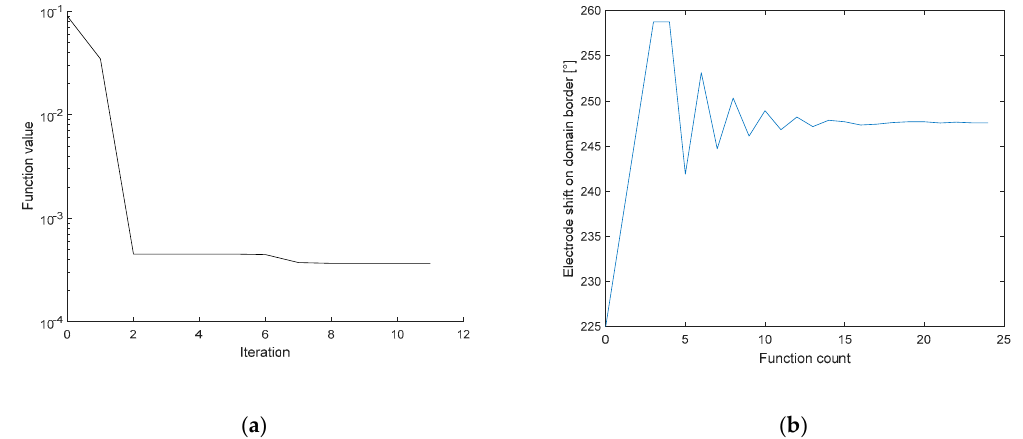
Figure 12. The optimization of the 6th electrode shifts on the domain border, represented with respect to the ( a ) error related to the position of the electrode, varying with iteration; ( b ) function count.